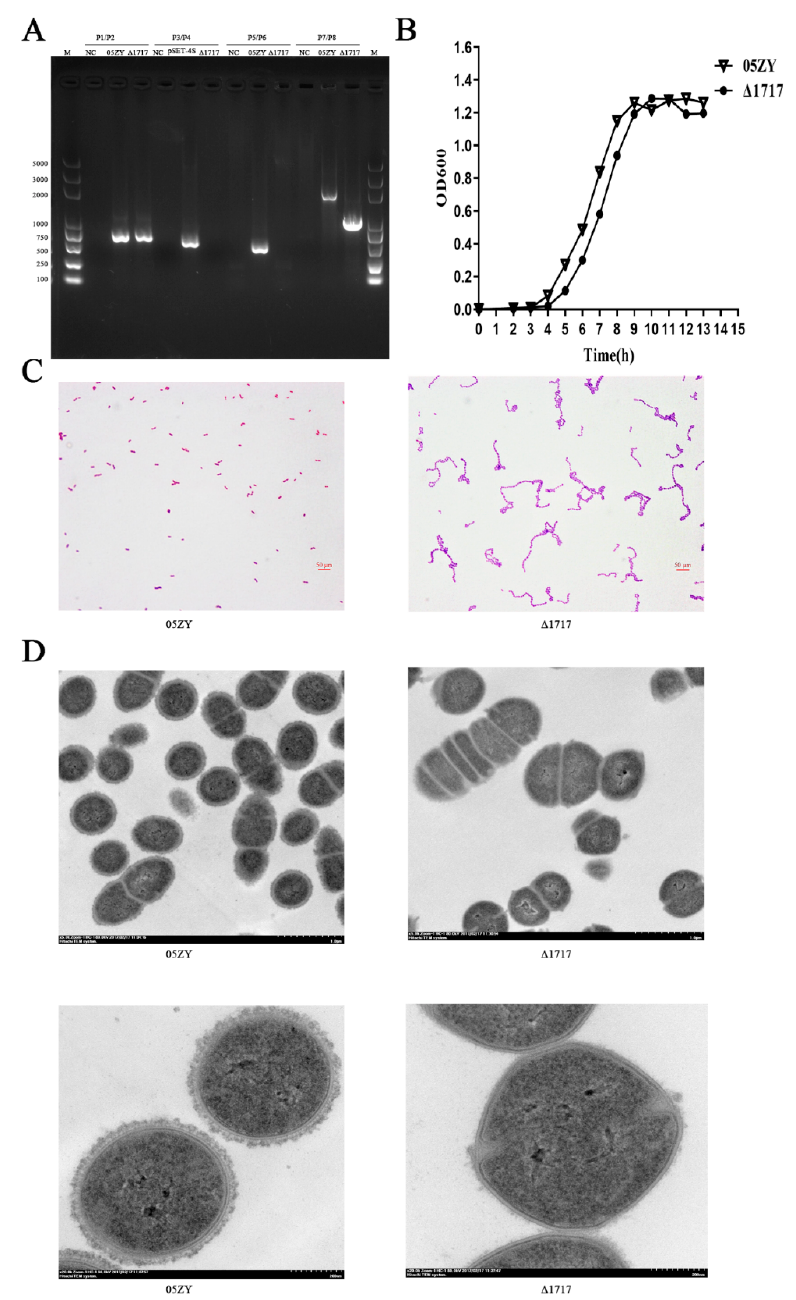
Figure 6. Construction and confirmation of the ∆ 1717 mutant. ( A ) Confirmation of the ∆ 1717 mutant by PCR using the primer pairs P1 / P2 (to detect the gdh gene), P3 / P4 (to detect the pSET4s vector), P5 /